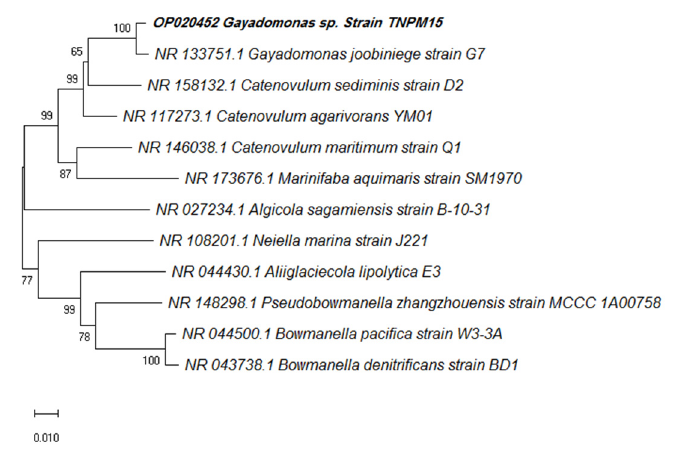
Figure 2. Phylogenetic tree showing the relationships between Gayadomonas sp. TNPM15 and the most closely related species.